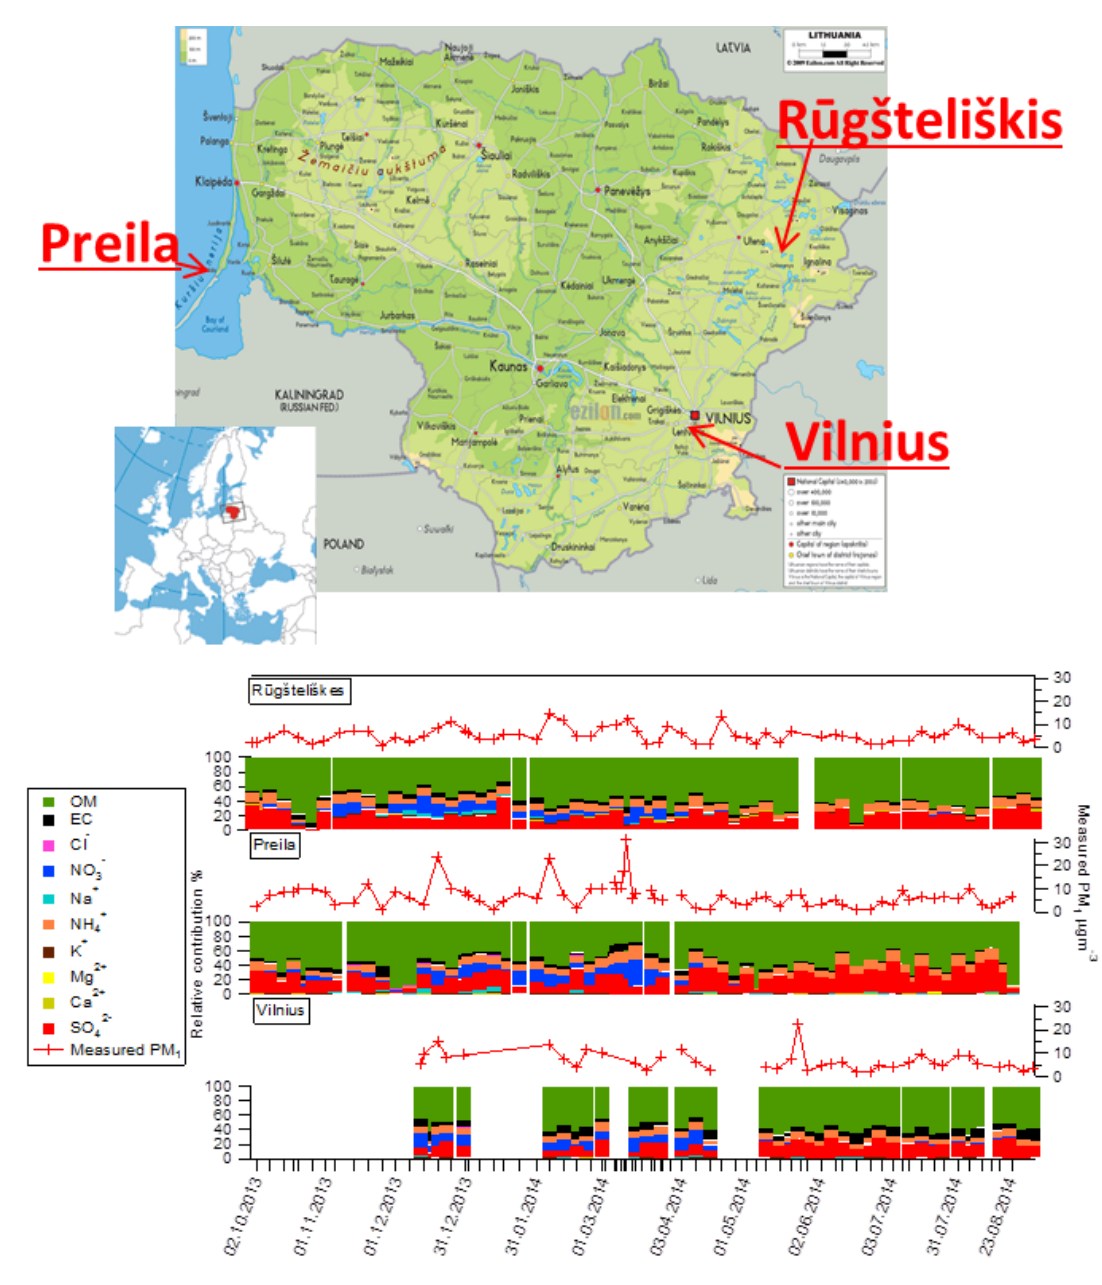
Figure 1. Sampling locations and measured PM 1